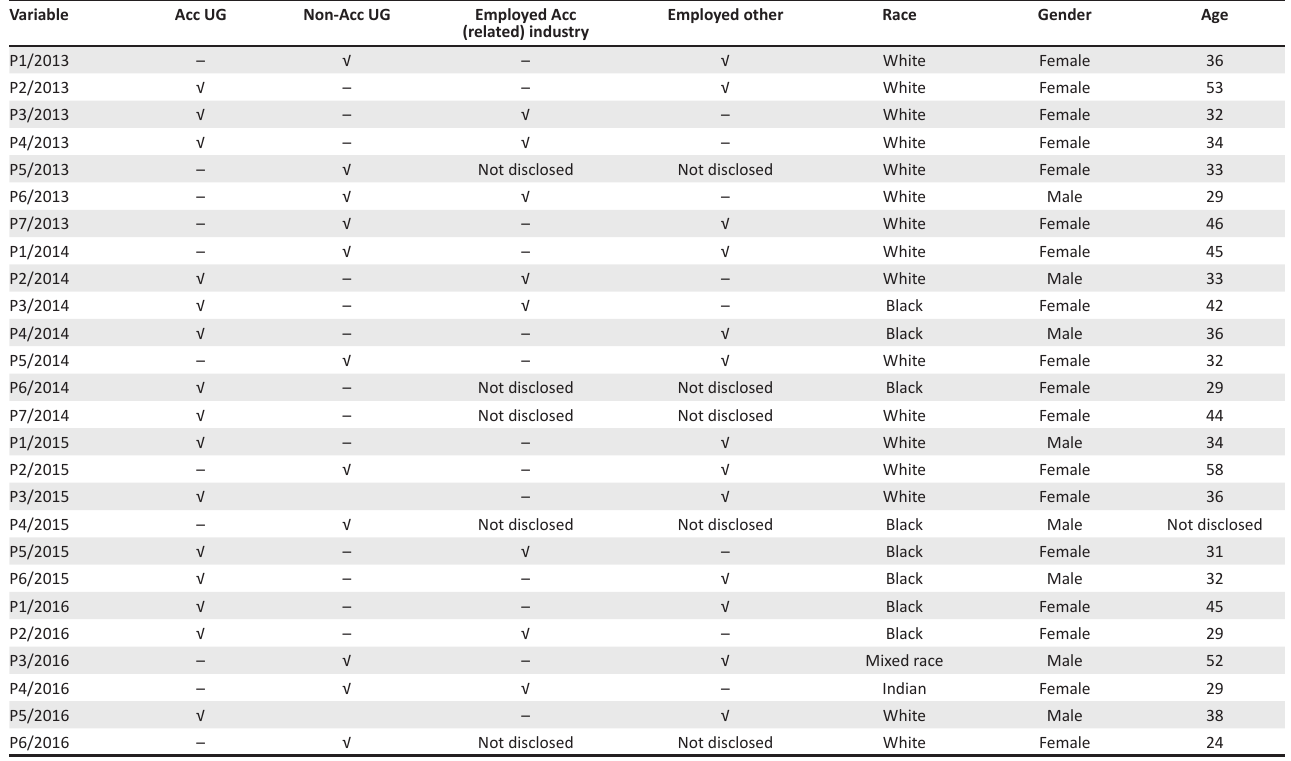
TABLE 1: Background information on participants.